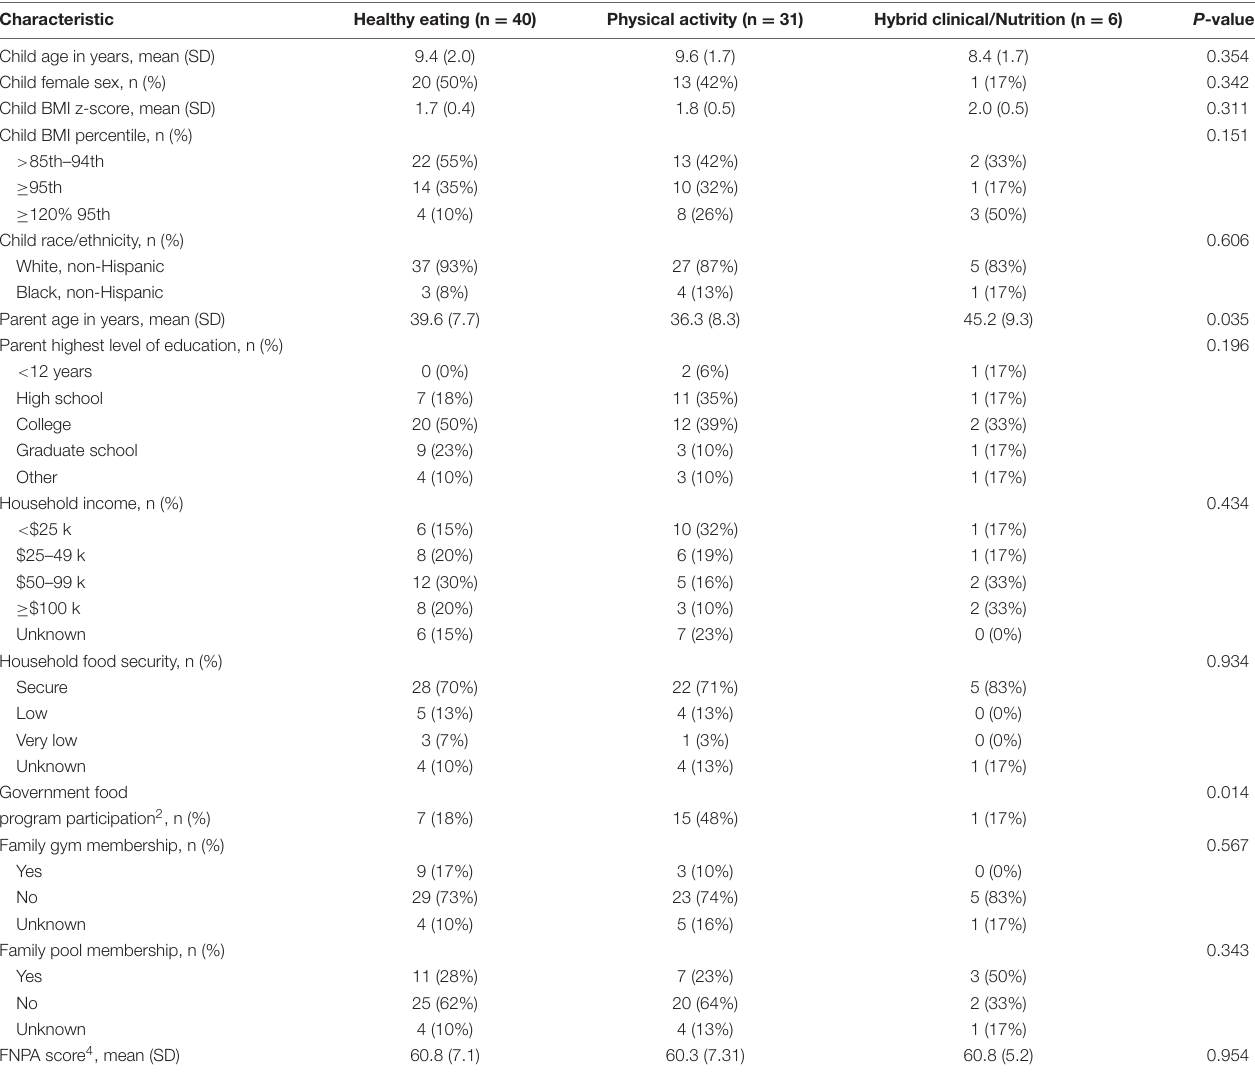
TABLE 1 | Characteristics of parent/child dyads enrolled in Enhanced PREVENT, by intervention.